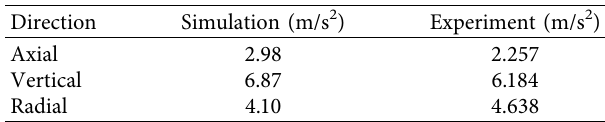
Table 16: Comparisons between simulations and test (the optimal